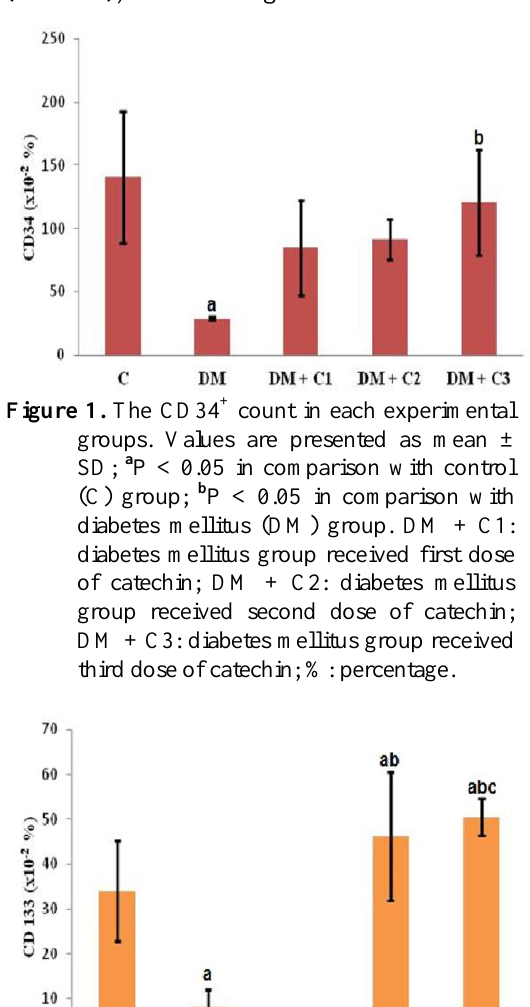
Figure 4. The serum SDF-1  level (A) and aorta expression of SDF-1  (B) in each experimental groups. Values are presented as mean ± SD; a P < 0.05 in comparison with control (C) group; b P < 0.05 in comparison with diabetes mellitus (DM) group; c P < 0.05 in comparison with first dose catechin administered (DM + C1) group; DM + C2: diabetes mellitus group received second dose of catechin; DM + C3: diabetes mellitus group received third dose of catechin; SDF-1  : stromal derived factor-1  ; ng/ml: